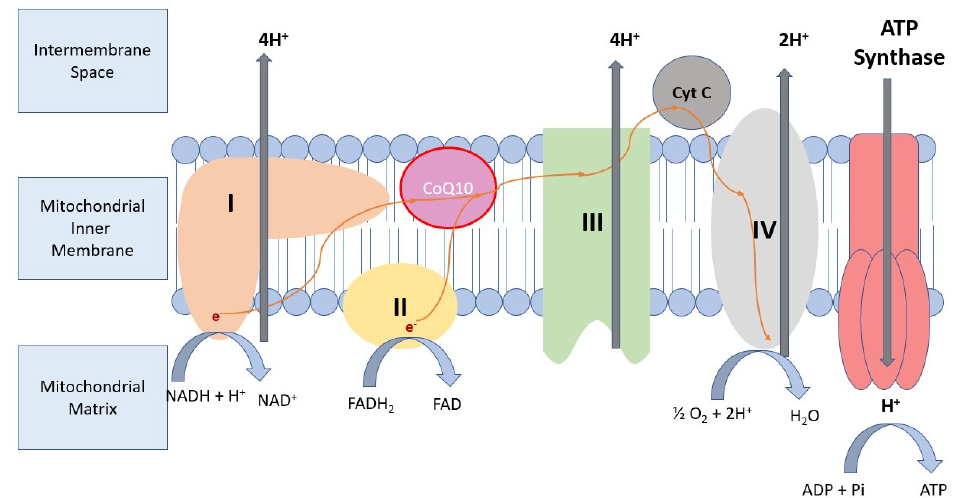
Figure 1. Role of CoQ10 in the mitochondrial electron transport chain. CoQ10—lipid-soluble component of the mitochondrial inner membrane, which acts as an electron acceptor at the level of the mitochondrial respiratory chain. CoQ10 carries electrons from complex I and complex II to complex III, contributing to ATP production. ADP: Adenosine diphosphate; CoQ10: Coenzyme Q10;Cyt C: Cytochrome C; e − : electron; FAD: flavin adenine dinucleotide; FADH: reduced flavin adenine dinucleotide; H+: proton; Pi: inorganic phosphate.